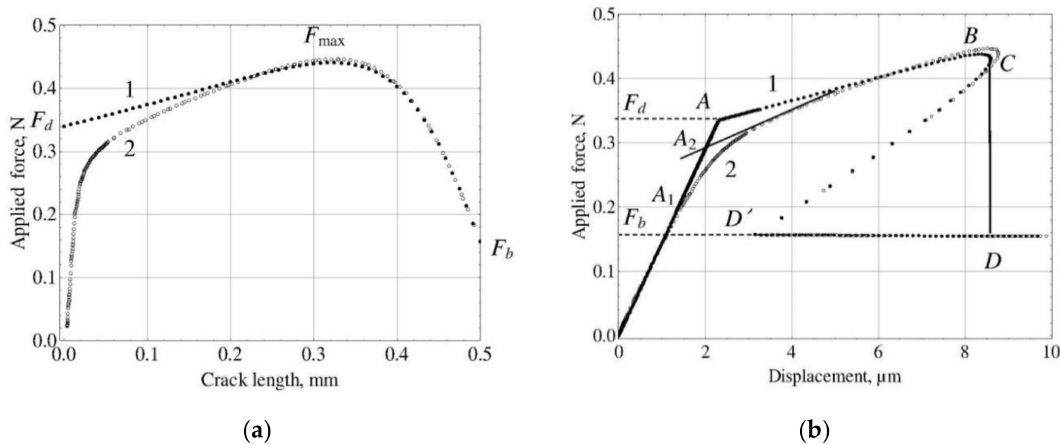
Figure 4. Force–crack length ( a ) and force–displacement ( b ) curves simulated for the glass fiber–epoxy matrix system. The embedded length is 500 µ m. Curves 1 correspond to the equivalent cylinder; curves 2, to the real-shaped